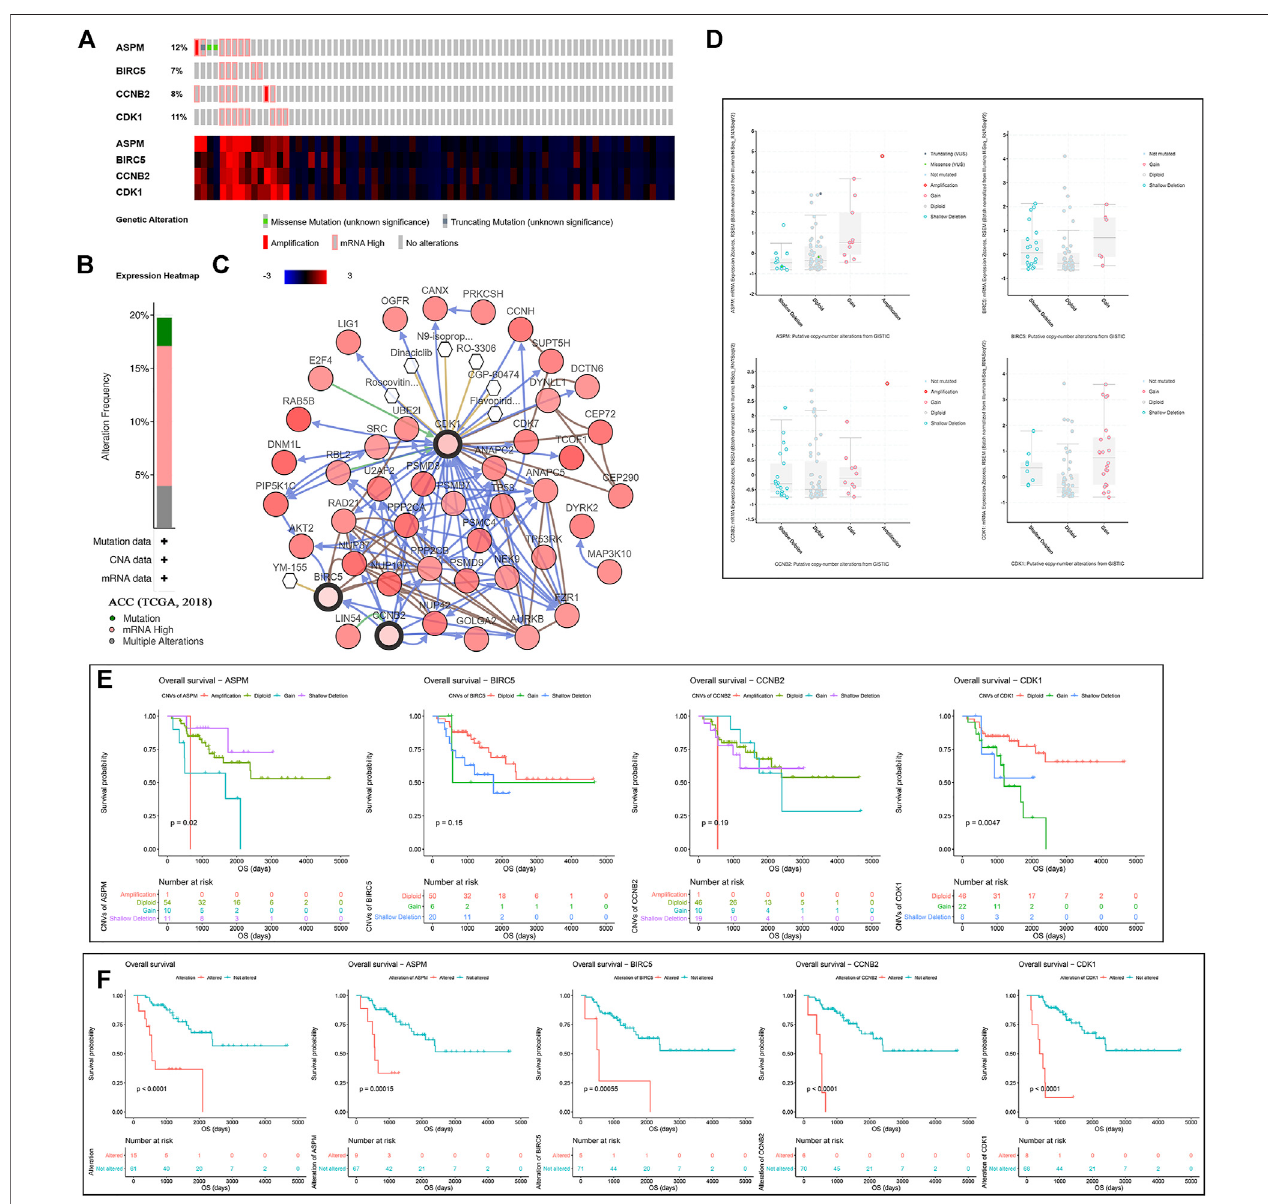
FIGURE5| Asummaryofmutations and CNVs ofMPBs. (A) Genetic alterations associated withMPBs and expression heatmap ofMPBs basedonthe datafrom TCGA. (B) ThetotalalterationfrequencyofMPBsinTCGA-ACCisillustrated. (C) Thenetworkcontains54nodes,includingour4querygenesandthe50mostfrequently altered neighbor genes. The relationship between hub genes and tumor drugs is also illustrated. (D) Correlation between different CNV patterns and mRNA expression levels of MPBs respectively. (E) Survival analysis of ACC patients with CNVs of MPBs based on TCGA ACC data. (F) Survival analysis of ACC patients with mutations of MPBs based on TCGA ACC